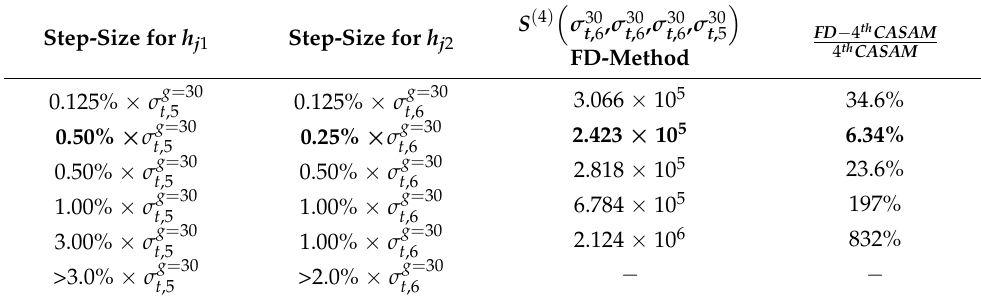
(cid:17) (cid:16) σ 30 using Equation (8) with various step-sizes. , σ 30 , σ 30 , σ 30 t ,6 t ,6 t ,6 t ,5